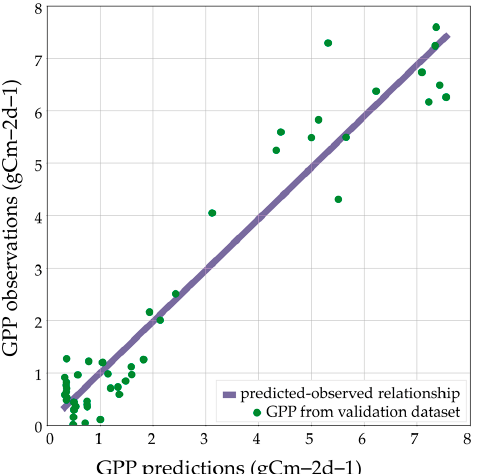
Figure 7. Scatter plot with fitted regression line showing the correlation between the predicted GPP values ( x -axis) obtained by our model and the observed GPP values ( y -axis).